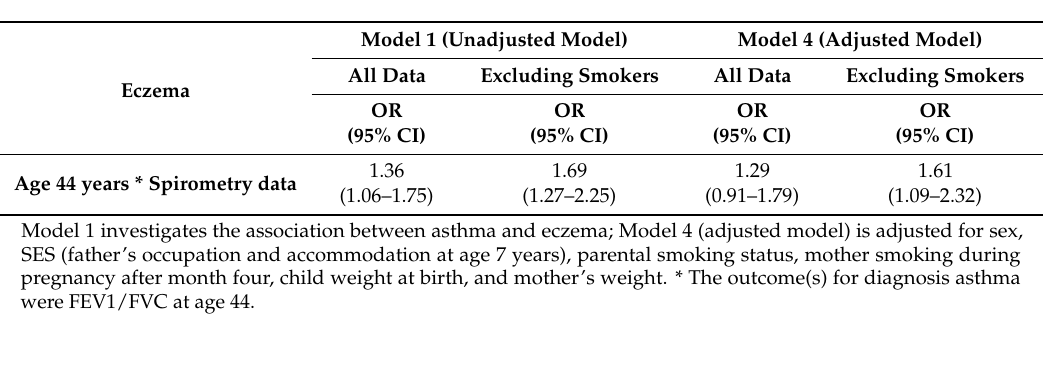
Table 3. Association between asthma and childhood eczema adjusting for sex, SES, parental smoking, mother smoking status after month four of pregnancy, birth weight of subject, and mother’s weight at pregnancy period for ages 44–46 years for biochemical data. The analysis was repeated after excluding the participants who smoked tobacco during the